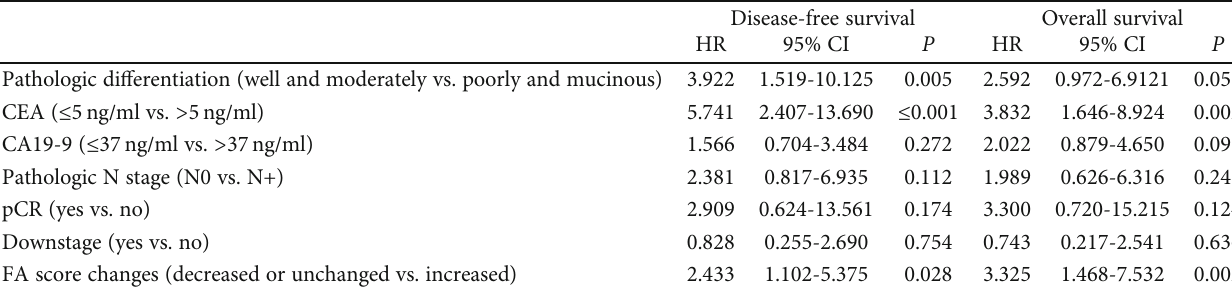
Table 4: Multivariate analysis for 3-year DFS and OS.